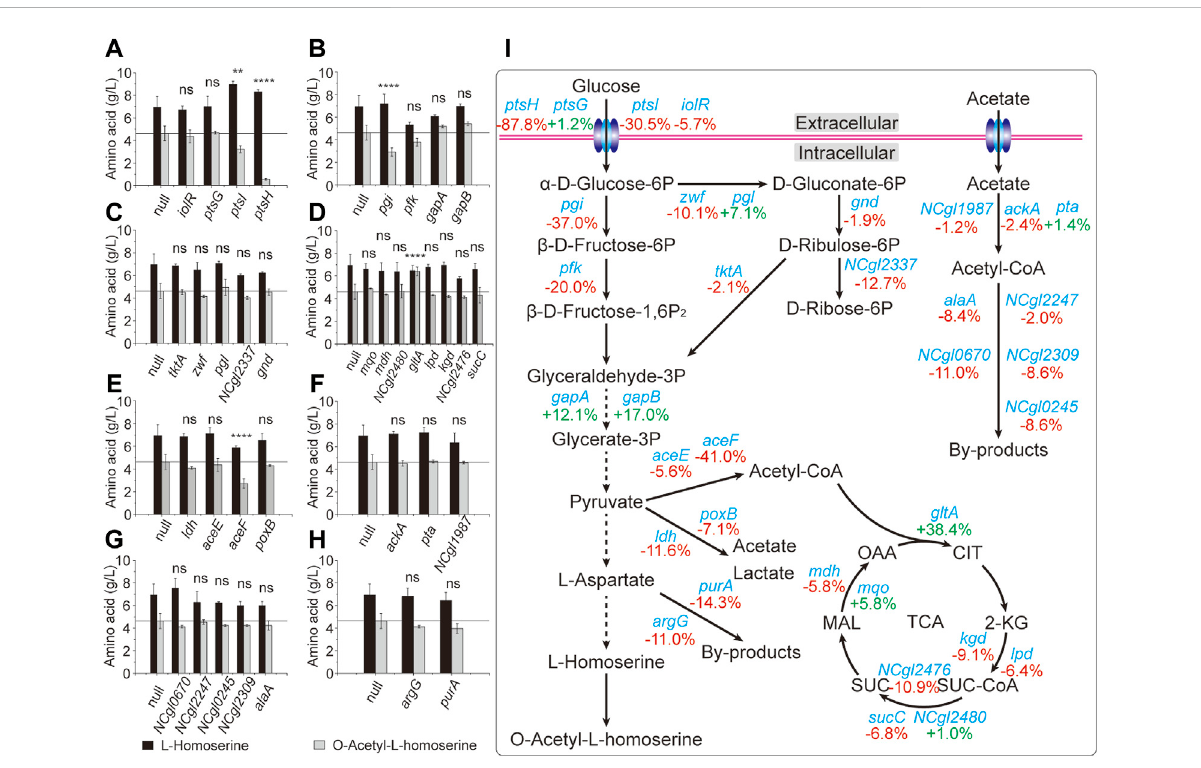
Identi fi cation of the key genes through the CRISPR-dCas9 system. The results of inhibition of different genes. (A) The genes of glucose transport. (B) The genes of glycolytic pathway. (C) The genes of pentose phosphate pathway. (D) The genes of TCA cycle. (E) The genes of pyruvate catabolism. (F) Thegenesofacetateacylation. (G) Thegenesofacetyl-CoA utilization. (H) Thegenesof L -asparticaciddegradationandmetabolism. (I) The overall schematic diagram. Error bars are standard deviation of triplicate experiments. Statistical signi fi cance was determined with